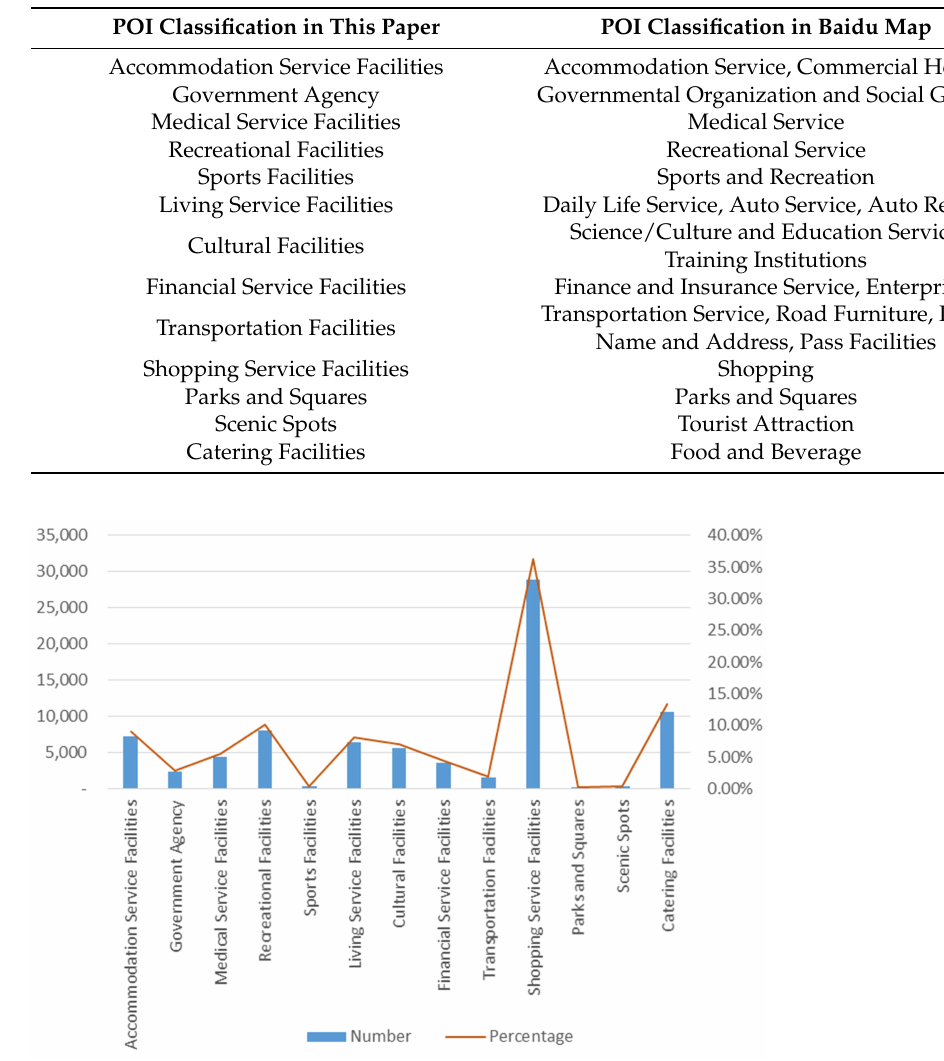
Figure 5. Example of street-view image. Table 1. POI reclassification.